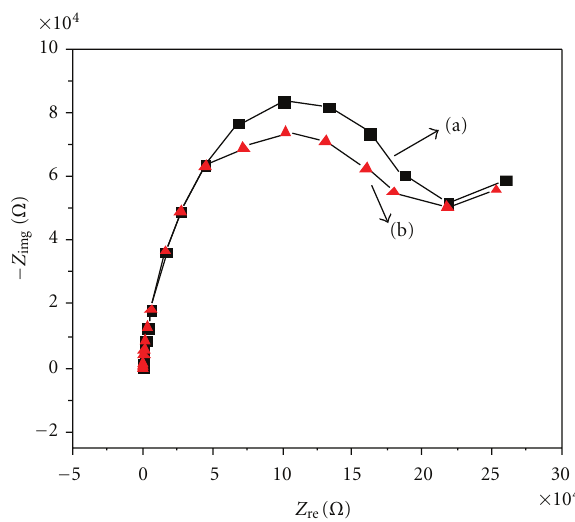
Figure 2: Impedance spectra of (a) bare gold electrode; (b) bare gold electrode functionalized with magnetic nanoparticles.